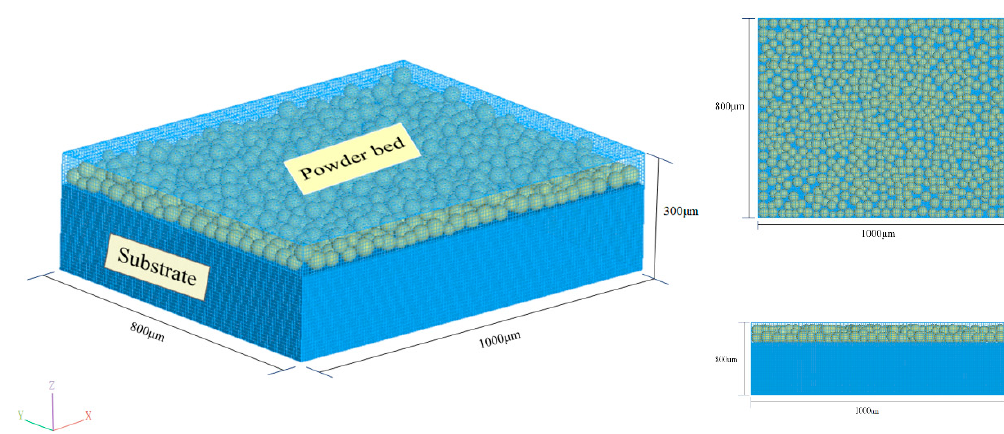
Figure 2. The computational domain of the 3D molten pool heat transfer simulation.